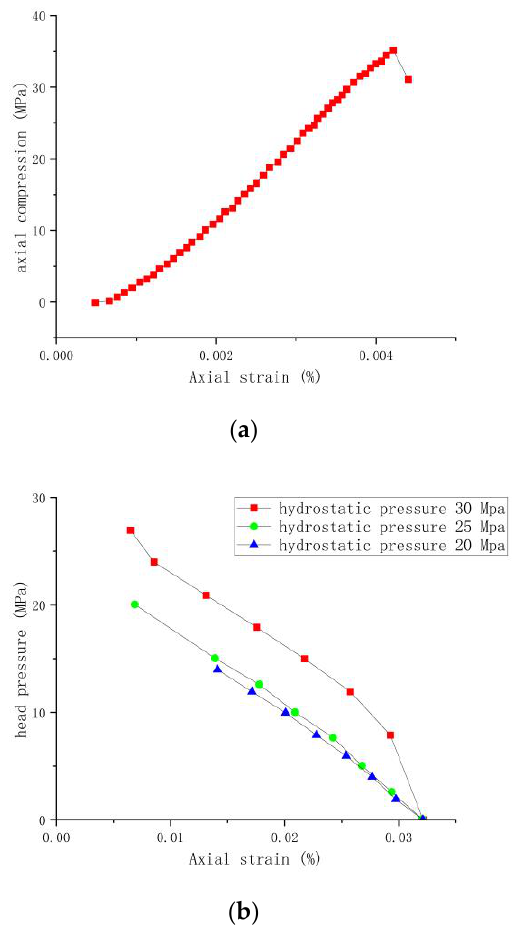
Figure 4. Experiment results for Sample 2#. ( a ) Stress–strain curve. ( b ) Post-peak strain–head pressure curve.